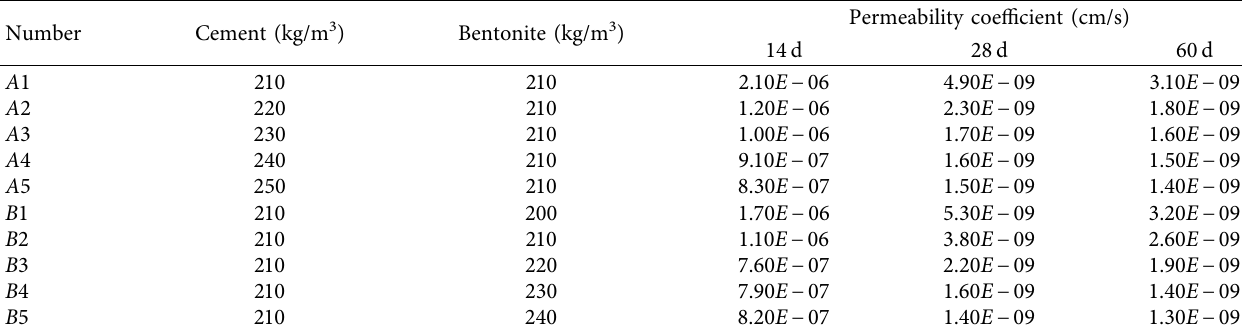
Figure 3: (a) Curve of influence of cement content on sample permeability coefficient; (b) curve of influence of bentonite content on sample permeability coefficient; (c) curve of influence of sodium carbonate content on sample permeability coefficient; (d) curve of influence of CMC-Na content on sample permeability coefficient. Table 5: Effects of cement and bentonite content on permeability coefficient of test